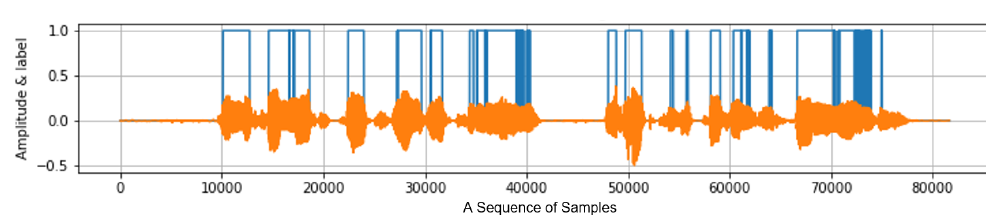
Figure 8. The ideal answer of the speech segment detection.